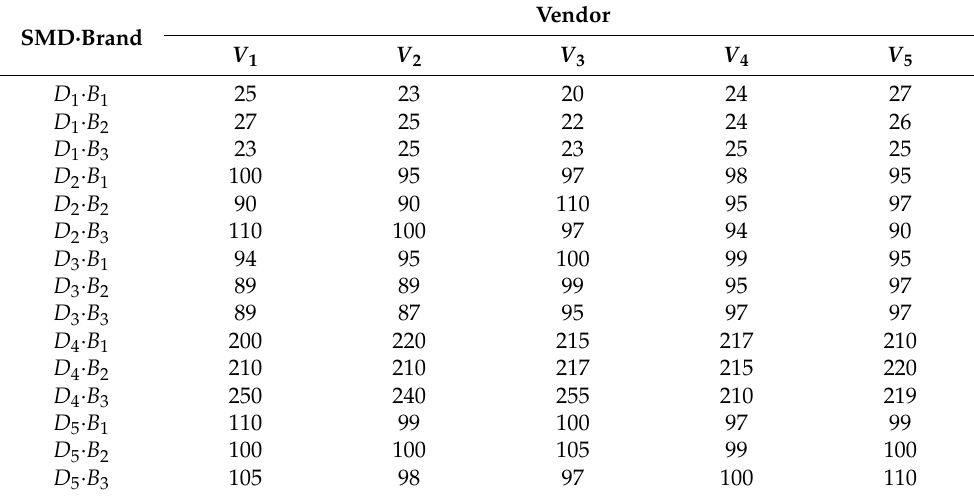
Table 12. The cost of SMD type (in